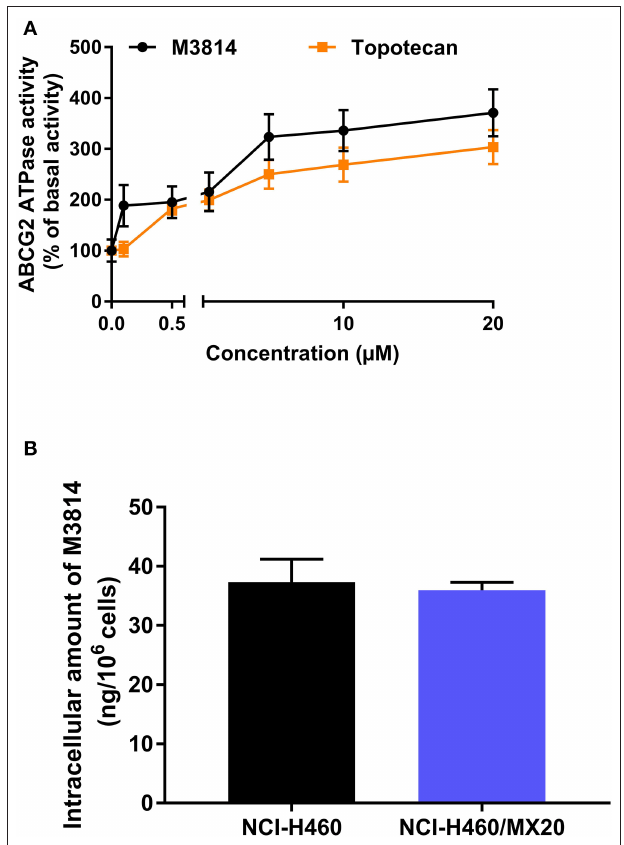
FIGURE 5 | M3814 stimulates ABCG2 ATPase activity without being transported out of the resistant cells (A) The effect of M3814 and topotecan on the ATPase activity of ABCG2 transporter. (B) The intracellular accumulation of M3814 in NCI-H460 and NCI-H460/MX20. Data are expressed as mean ± SD from three independent